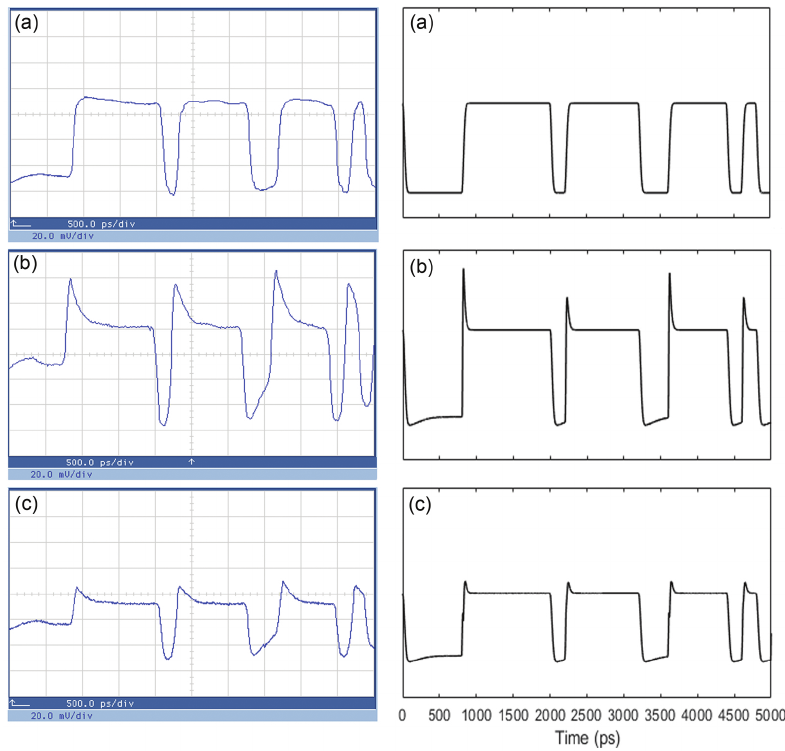
Figure 5. Representative pulse stream profile at the RSOA input ( a ), RSOA output ( b ) and BFL output ( c ). Left column: experimental results. Right column: simulation results.